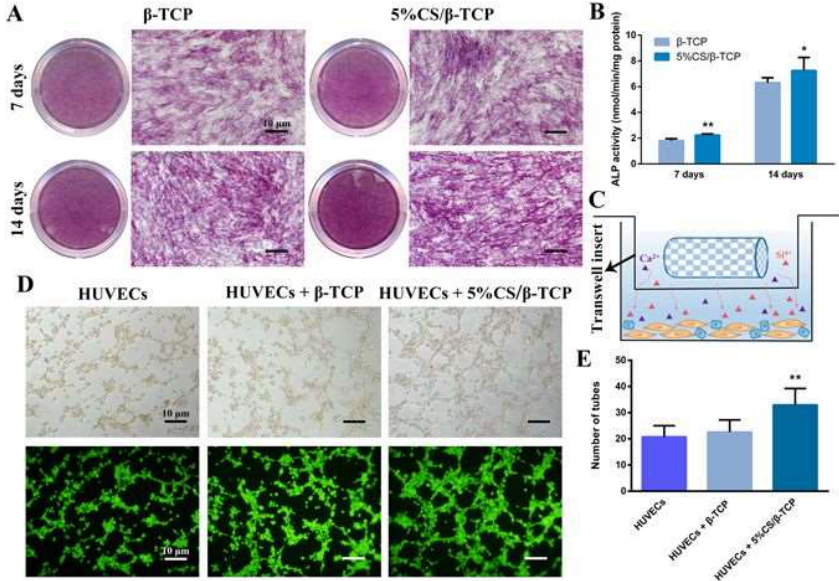
Figure 4. Five percent calcium silicate (CS)/β-TCP scaffolds stimulated human bone marrow stromal cell (hBMSC) osteogenesis and human umbilical cord vein endothelial cell (HUVEC) angiogenesis in vitro. ( A ) Alkaline phosphatase (ALP) staining in hBMSCs cultured for 7 and 14 days with β-TCP scaffolds or 5% CS/β-TCP scaffolds in transwell inserts. ( B ) 5% CS/β-TCP scaffolds stimulated ALP activity at 7 days and 14 days in comparison to pure β-TCP. ( C ) Schematic representation of transwell experiments. Scaffolds in transwell inserts (upper chamber), cells in the lower chamber. ( D ) Tube formation by HUVECs, as observed by light microscopy (top) and calcein acetoxymethyl (AM) staining (bottom), after 4 h on Matrigel with β-TCP or 5% CS/β-TCP scaffolds in transwell inserts; ( E ) 5% CS/β-TCP scaffolds enhanced tube formation in comparison to β-TCP scaffolds. * p < 0.05; ** p < 0.01. Scale bar represents 10 μm. Reprinted from [161], published under a Creative Commons Attribution 4.0 International License, 2017.